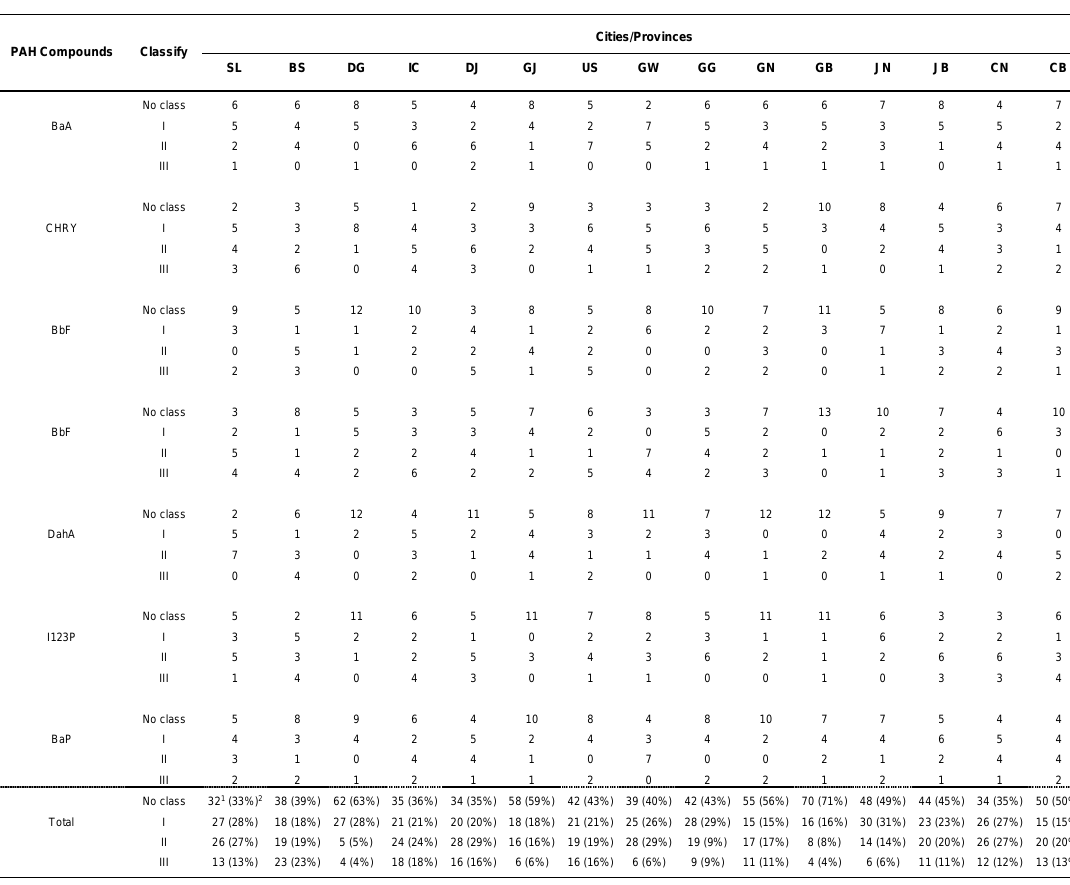
B. Results of the correlations analysis between 7 PAH compounds for each city and/or province